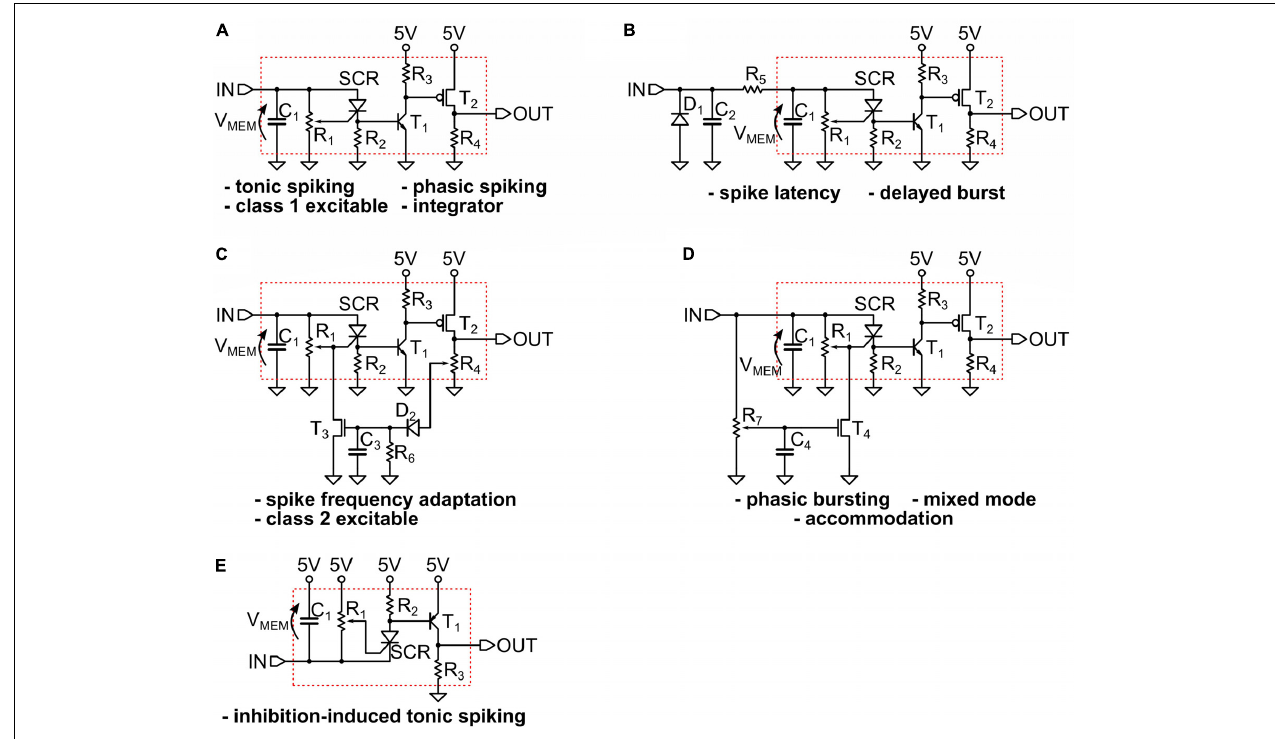
FIGURE 5 | (A–D) The circuits that implement the measured spiking behaviors shown in the Figure 3 . We indicate with an arrow the definition of the “membrane” voltage V MEM on the capacitor C 1 . The circuit adapted for negative input is shown in (E) , where we indicate with a red box the basic UCN block that is slightly modified with respect to the original. The specific values of the components are provided in Supplementary Material